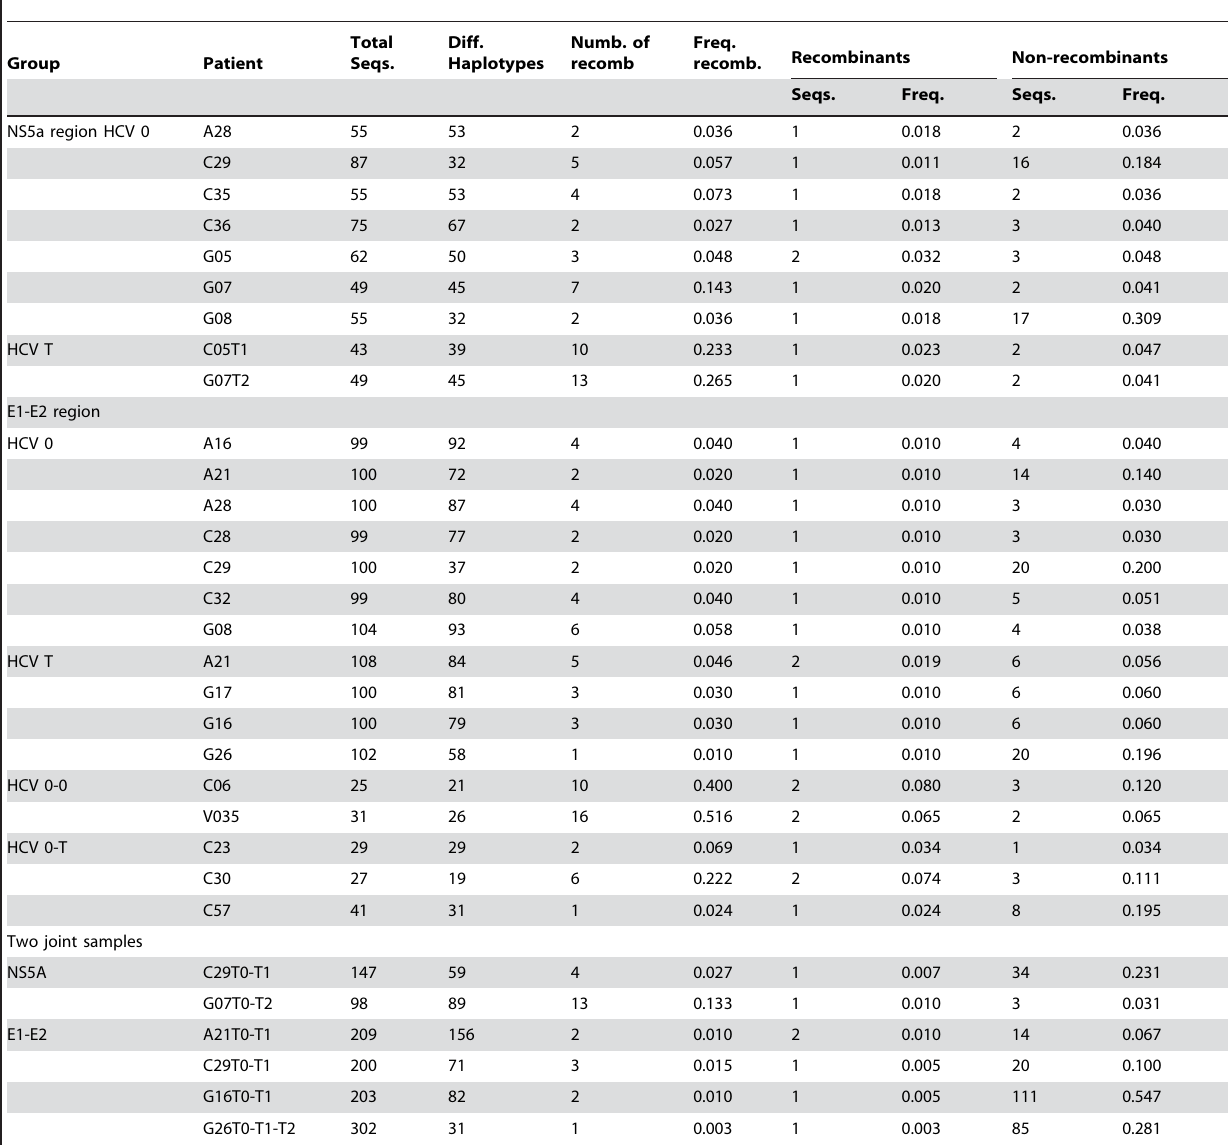
Table 2. Summary of frequency analysis of recombinant sequences in the different data sets where intrapatient recombination of HCV was